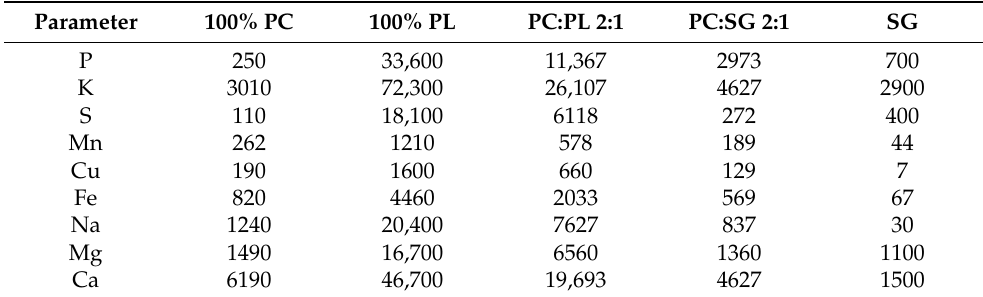
Table 1. Chemical composition of designer biochars and compost (PC = pine chips; PL = poultry litter; SG = switchgrass compost; units are mg kg − 1 , dry-basis).